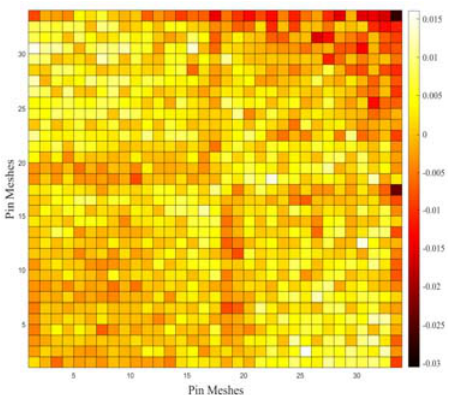
Figure 2. Distribution of pin FRD difference of C5G7 benchmark fuel region during group